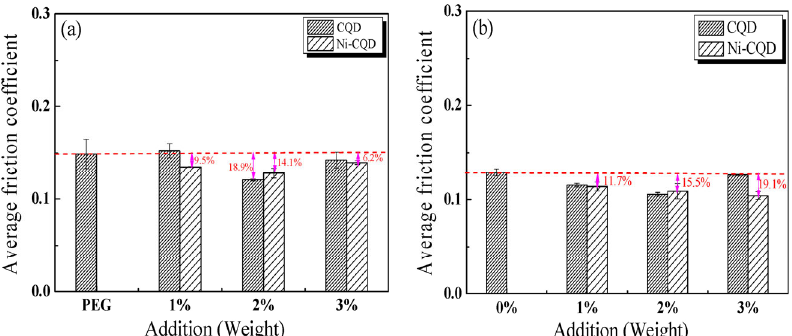
Fig. 4 Variation of average friction coefficient for different oil samples including the 1 wt%, 2 wt% and 3 wt% CQD or Ni-CQD particles at the load of 100 N for 60 min at room temperature conditions under different reciprocation speeds: (a) 17 mm/s; (b) 33